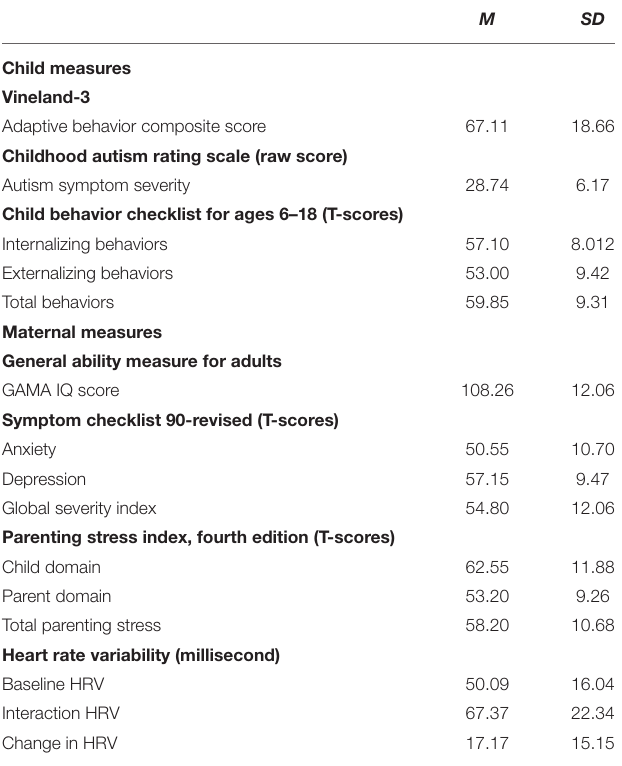
TABLE 2 | Means and standard deviations for child and maternal measures.